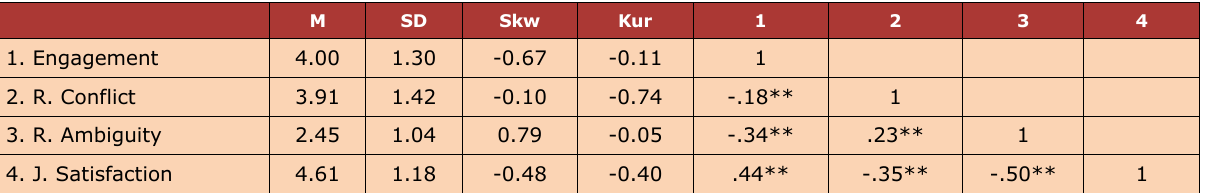
Table 1. Descriptive statistics and correlations of all study